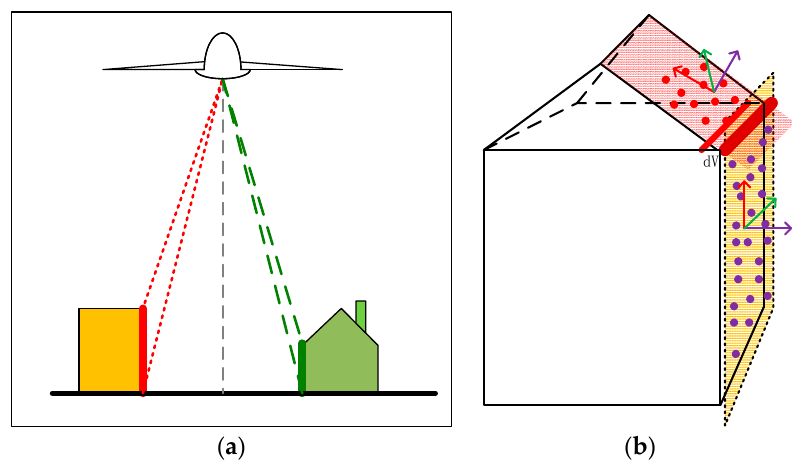
Figure 3. Line features extraction based on LiDAR point clouds: ( a ) LiDAR point clouds echoed from the wall; ( b ) the small cuboid formed by moving the wall or the roof plane along its normal direction.